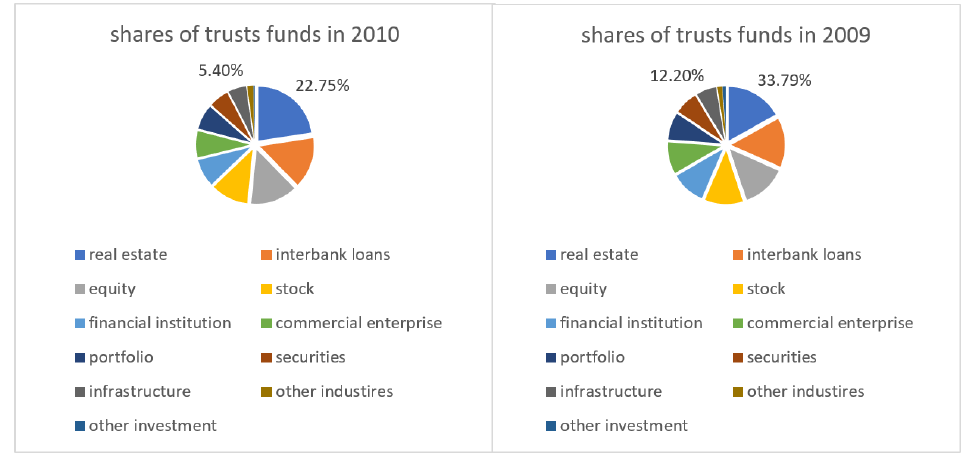
Figure 7. The proportion of financing to real estate sectors by investment trust corporations. Source: Wind Database.